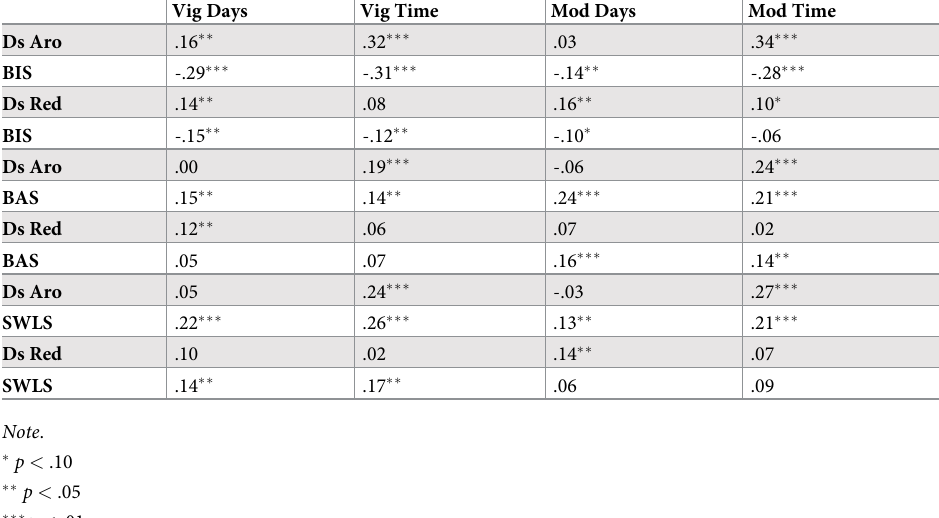
Table 10. Partial correlations of exercise variables with dissonance variables and BIS, BAS, and SWLS (the latter variables were simultaneous predictors; Study 2).